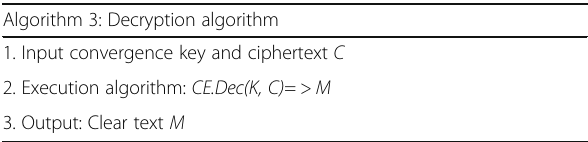
Algorithm 1: Convergence key generation algorithm